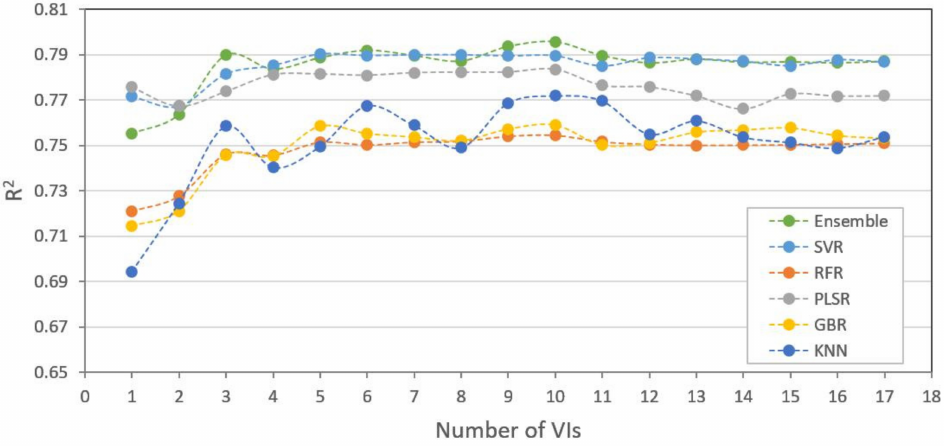
Figure A2. Model training accuracies as a function of the number of VIs derived from 0.045 m GSD multispectral data.